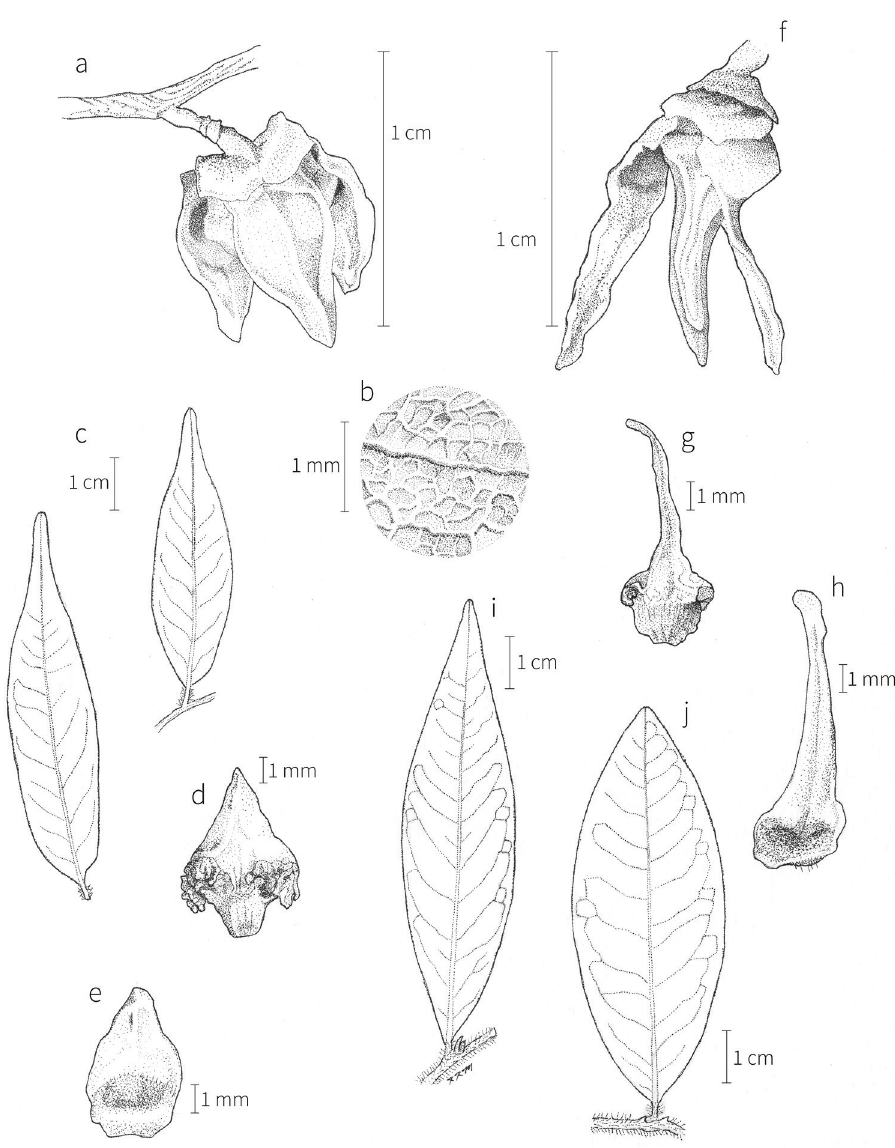
Figure 23. Xylopia flamignii and X. gilbertii . A–E X. flamignii A Flower, side view B Close-up of adaxial leaf surface, showing raised venation C Leaves D Inner petal, adaxial view E Outer petal, adaxial view F–J X. gilbertii F Flower, side view G Inner petal, adaxial view H Outer petal, adaxial view I, J Leaves. A–E from Bradley 1136 (OWU) F–I from Louis 6777 (MO) J from Letouzey 10707 (P). Description. Tree up to 30 m tall. Twigs dark brown to gray brown, eventually light brown or gray, initially appressed-pubescent, the hairs 0.1–0.2 mm long, soon glabrate; nodes occasionally with two axillary branches. Leaf with larger blades